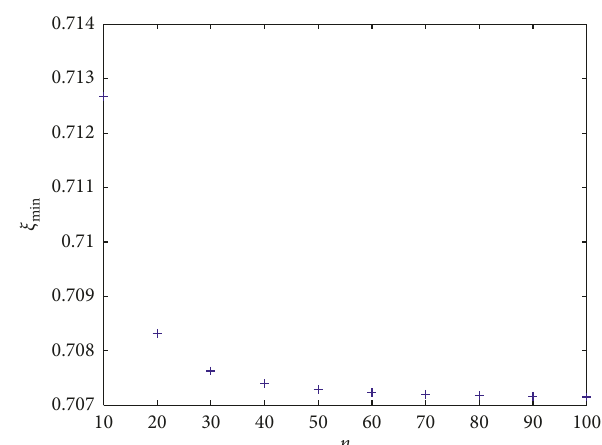
Figure 4: Minimum damping ratio for maximum stability margin approach depending on number of